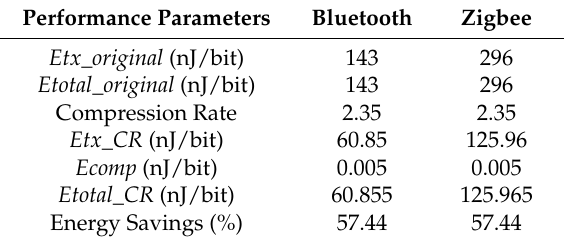
Table 4. Energy saving for Bluetooth and Zigbee wireless